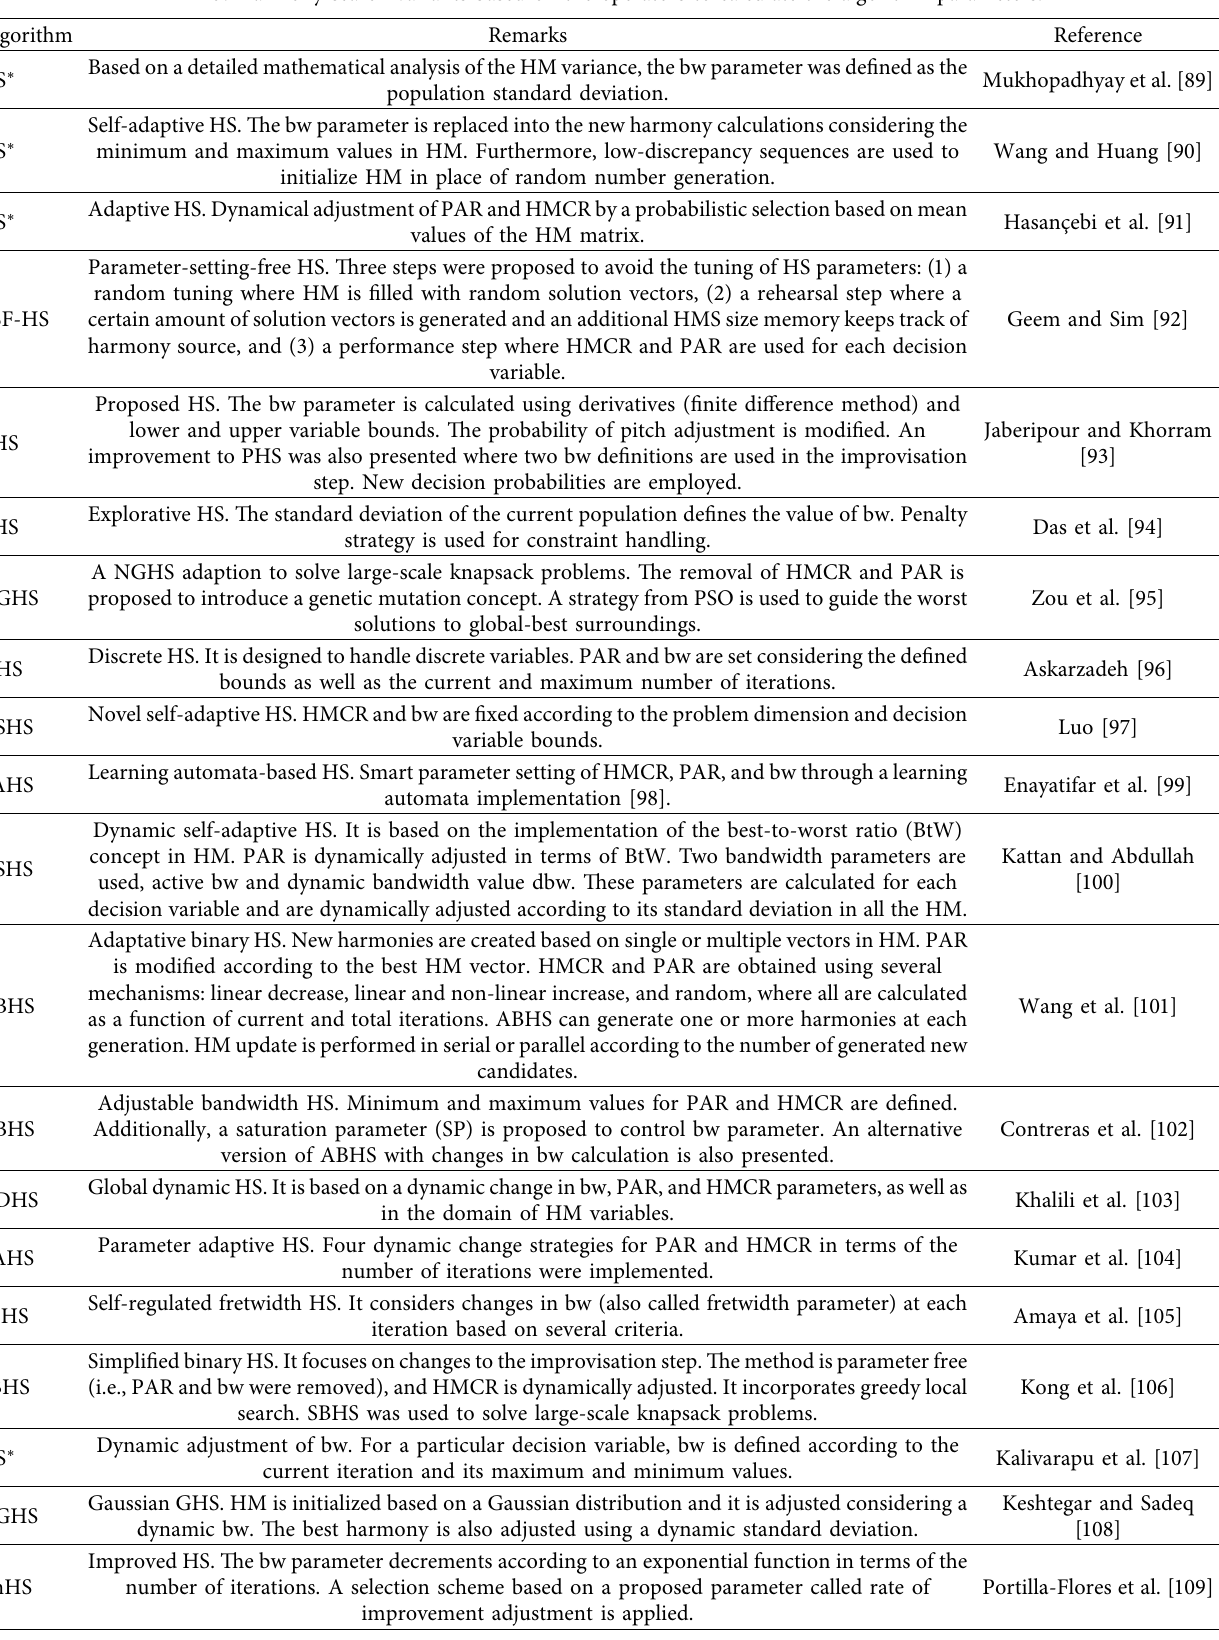
Table 3: Harmony search variants based on the operators to calculate the algorithm